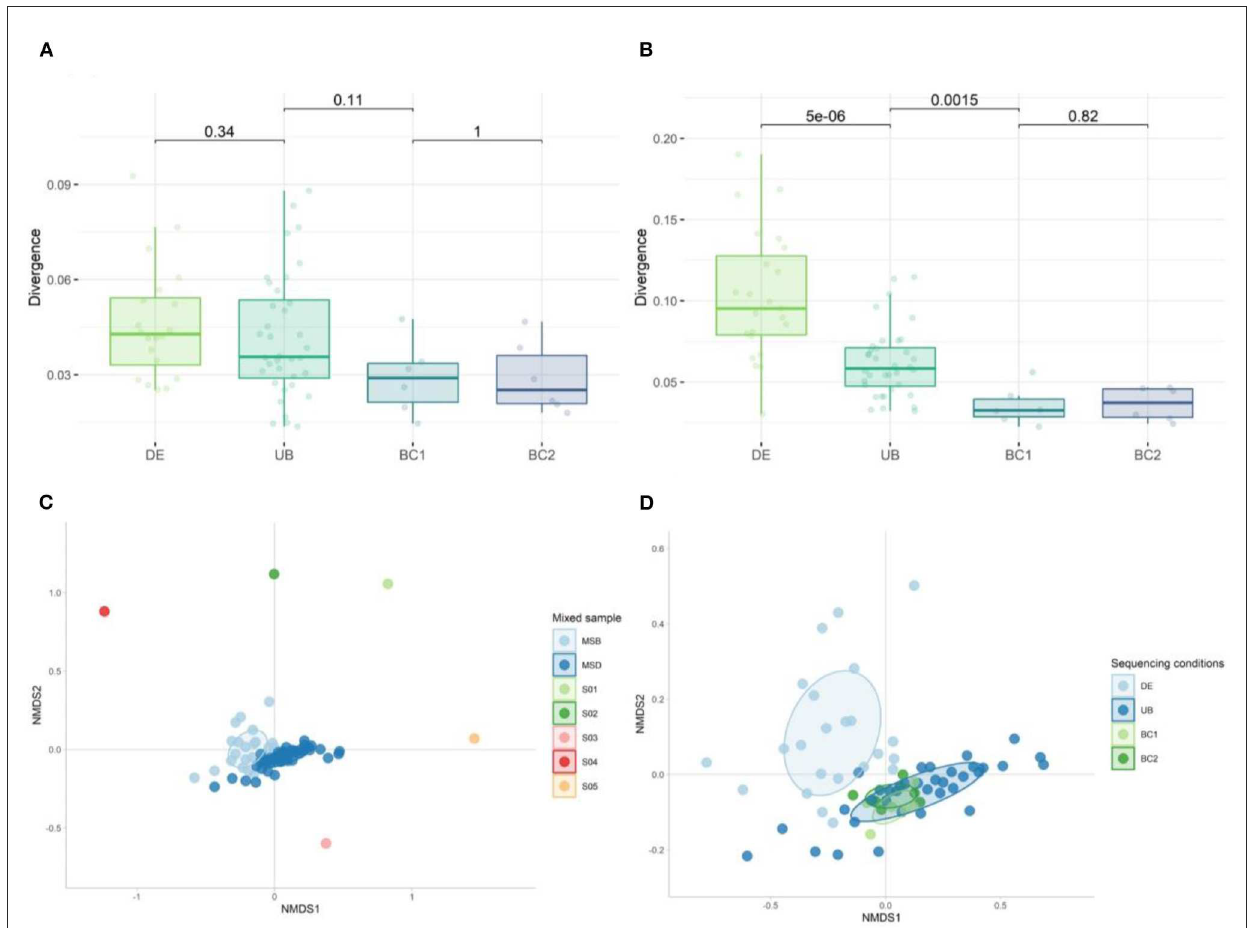
FIGURE13 Divergence of (A) mock samples and (B) mixed samples when comparing the effect of DNA extraction rounds and the use of different barcodes on the heterogeneity within the set of samples. The Wilcoxon test was used to calculate the adjusted p -values between all tested conditions. (C) Non-metric multidimensional scaling (NMDS) plot of the five donor samples (S01–S05) used to generate the mixed sample used as a positive control in DNA extraction (DE n = 23) and sequencing runs (UB n = 36, BC1 n = 6, and BC2 n = 6) ( n = 71). (D) NMDS plot of the 30 mixed samples sequenced: fecal samples extracted in different DNA extraction (DE) rounds, DNA samples amplified with unique barcodes (UBs), and DNA samples amplified with the same barcodes (BC1 and